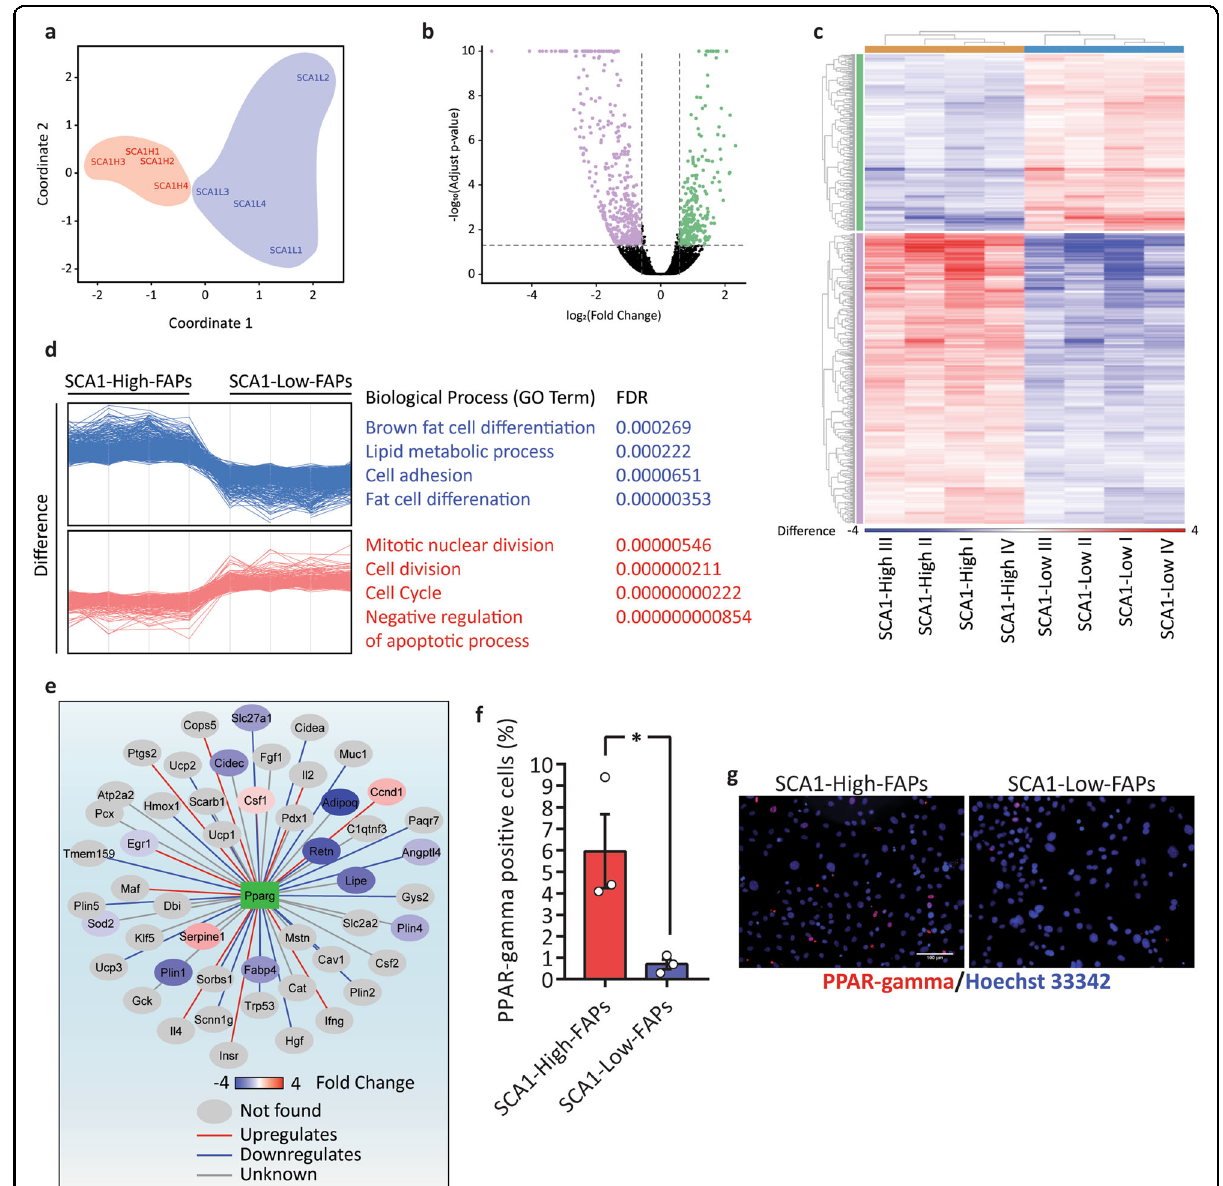
Fig. 5 SCA1-High-FAPs have a transcriptional pro fi le committed to the adipogenic differentiation. a Multidimensional scaling (MDS) plot of FAP cell states transcriptome. b Volcano plot of log10(adjust p -value) versus log2(fold change) showing upregulated (in green) and downregulated (in purple) genes in SCA1-Low-FAPs. c Heatmap of the Difference of the different biological replicates ( n = 4). d Pro fi le plots of the Difference of the downregulated (upper panel, purple cluster in Fig. 5c) and upregulated genes (lower panel, orange cluster in Fig. 5c) in SCA1-Low-FAPs. The right panel shows the top 4 Biological processes GO terms signi fi cantly enriched (FDR < 0.05) for upregulated and downregulated genes in SCA1-Low- FAPs. e A network in which each node represents a gene transcriptionally regulated by PPAR-gamma (from TRRUST). Red edges: genes activated by PPAR-gamma; blue edges: genes repressed by PPAR-gamma; grey edges: unknown mechanism. The nodes are fi lled according to the Fold Change. f Bar plot showing the percentage of PPAR-gamma positive cells after 5 days in GM ( n = 3). g Representative images of bar plot in the previous panel. PPAR-gamma in red and nuclei in blue. Scale bar 100 μ m. Statistical analysis was performed with Student ’ s t test. Data are presented as mean ± SEM. * p ≤